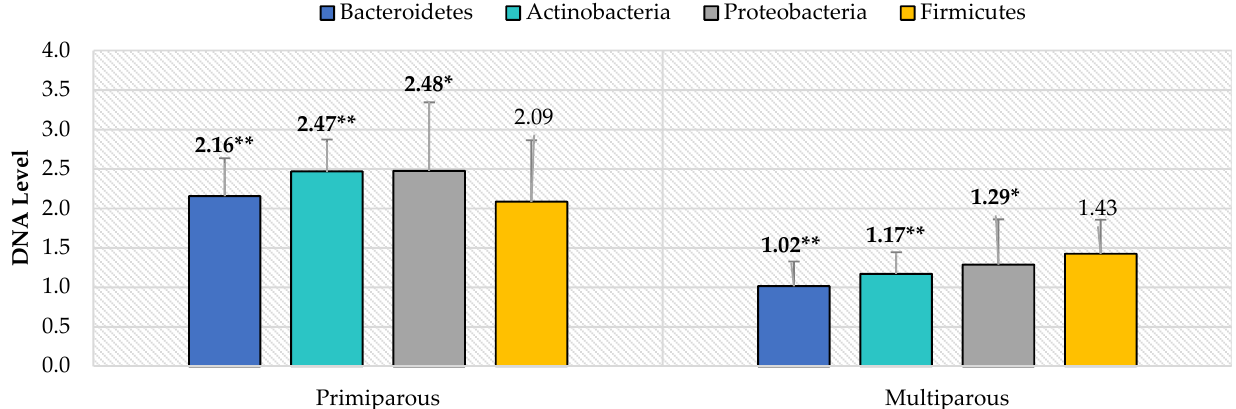
Figure 1. The level of selected bacterial phyla (RNE) in the gastrointestinal tract of ewes in relation to the parity based on feces (* p < 0.05; ** p < 0.01).